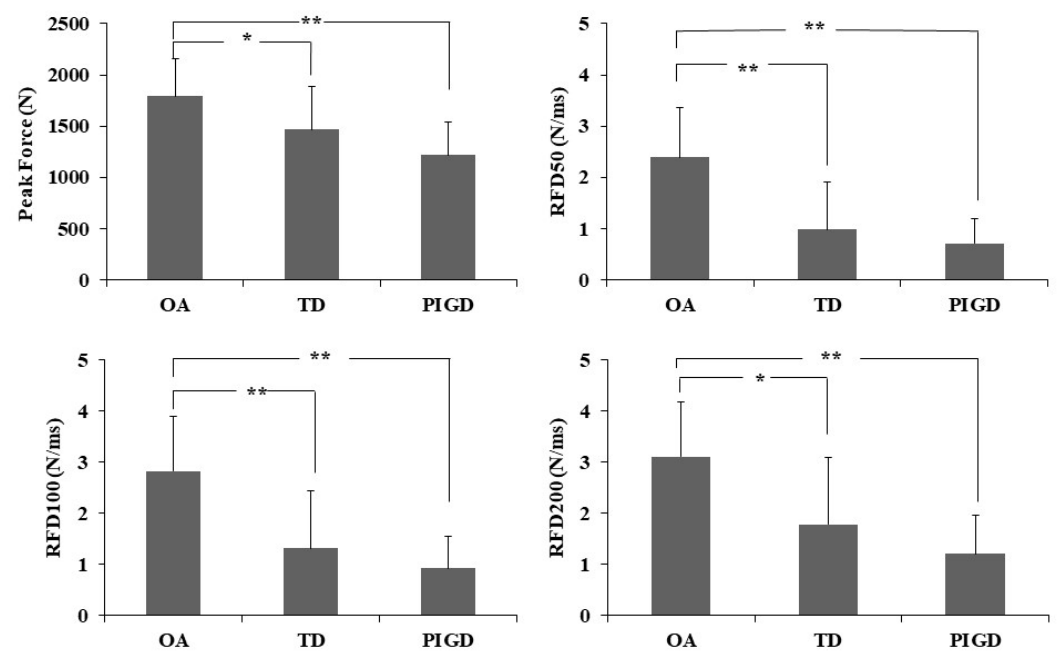
Figure 1. Force production comparisons between the OA, TD, and PIGD groups. Data are mean (SD). OA: older adults; TD: tremor-dominant group; PIGD: postural instability and gait difficulty group; RFD: rate of force development. * p < 0.05 and ** p < 0.001.